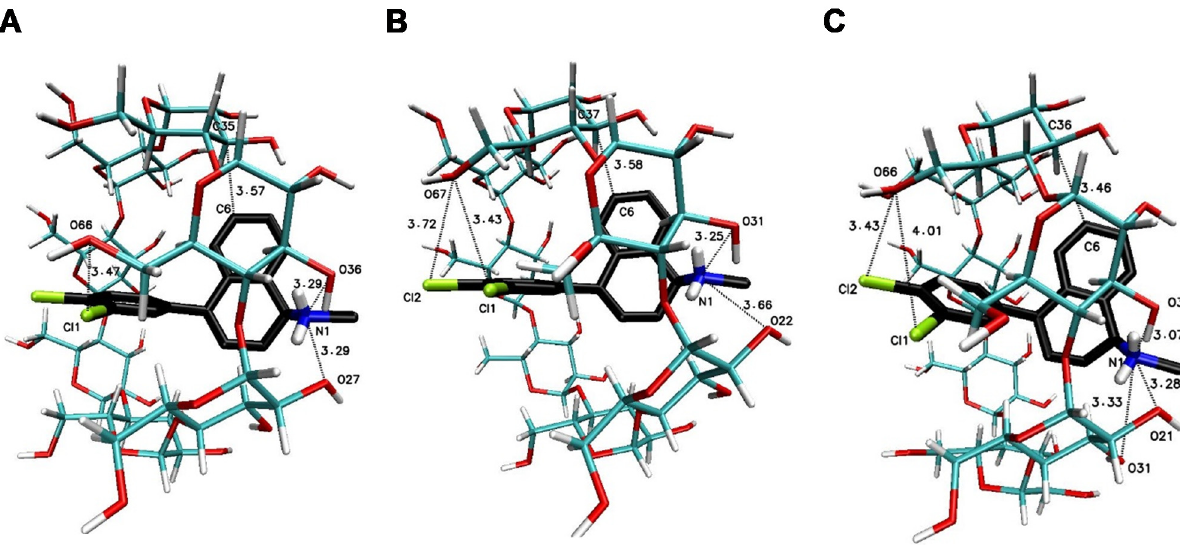
Figure 9. The geometries of the SRT- β CD complex with stoichiometry 1:1-I for ( A ), II for ( B ) and III for ( C )-obtained by MD simulations with the use of β CD crystal structure with refcode 648855 [67] from the CSD database [47].